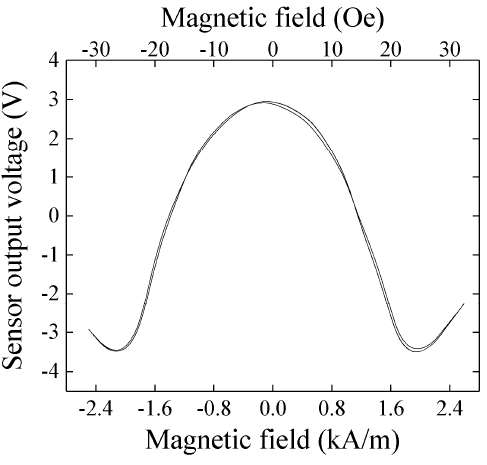
Figure 8. Measured result when a normal magnetic field B Z = 0.11 T.